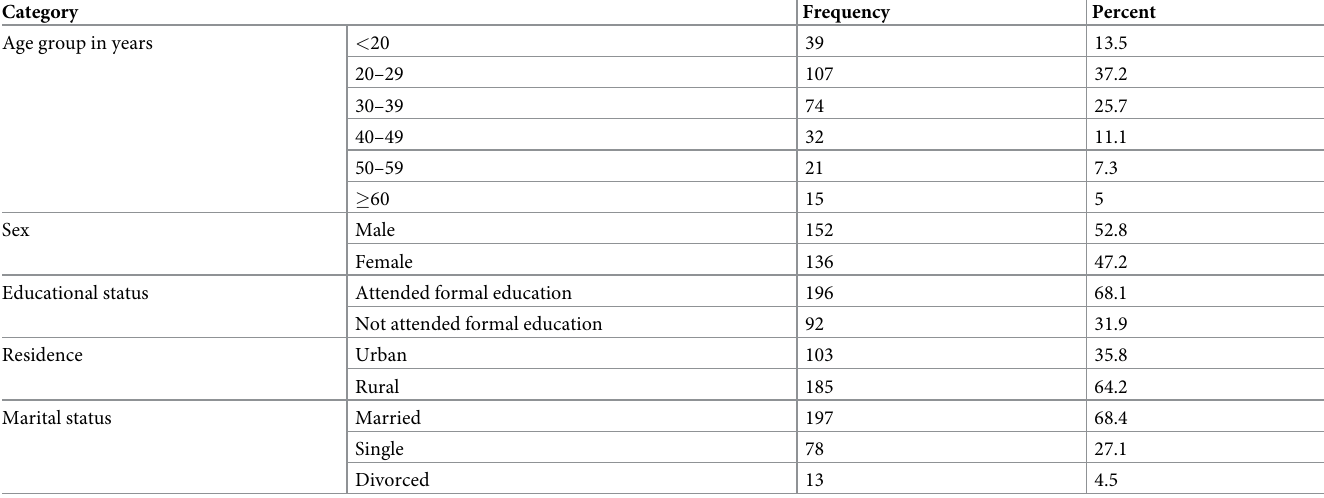
Table 1. Socio-demographic characteristics of patients attending the dental clinic in Shashamane Comprehensive Specialized Hospital, southeast Oromia, Ethio- pian, 2021 (N = 288). Category Age group in